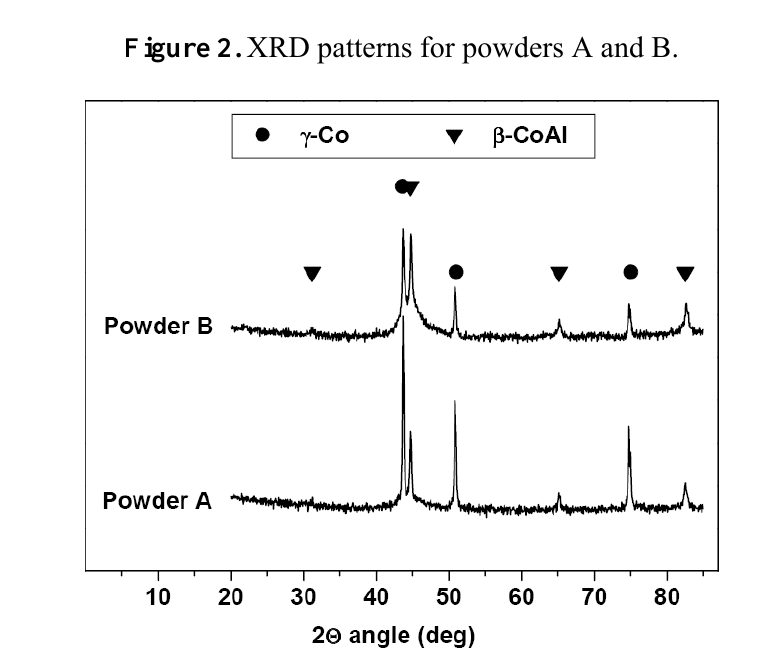
Figure 2. XRD patterns for powders A and